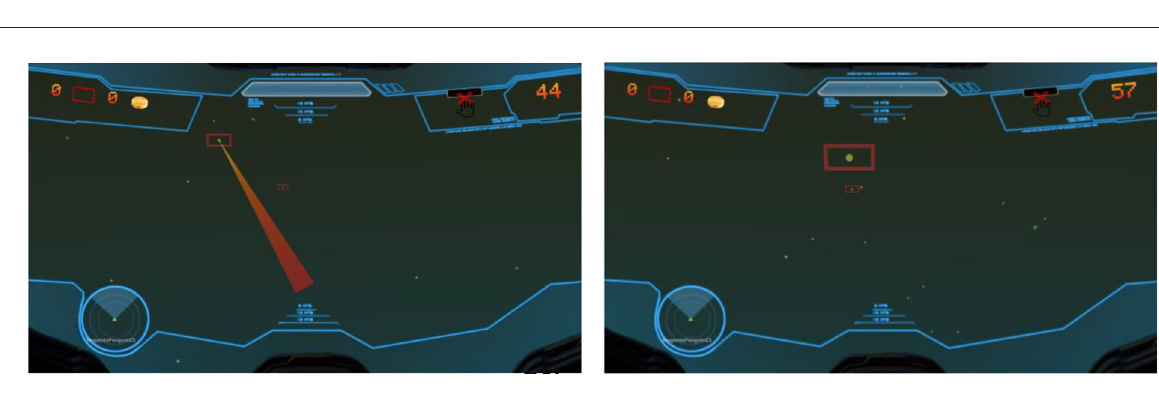
FIGURE5 Variant 2 of the game. The user is “transferred” inside the virtual airplane, to immerse the user and make him feel that his hand is the virtual